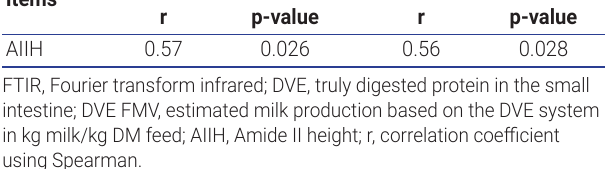
Table 14. Correlation study between FTIR protein structures of Can- ola meals and the DVE/OEB system Items